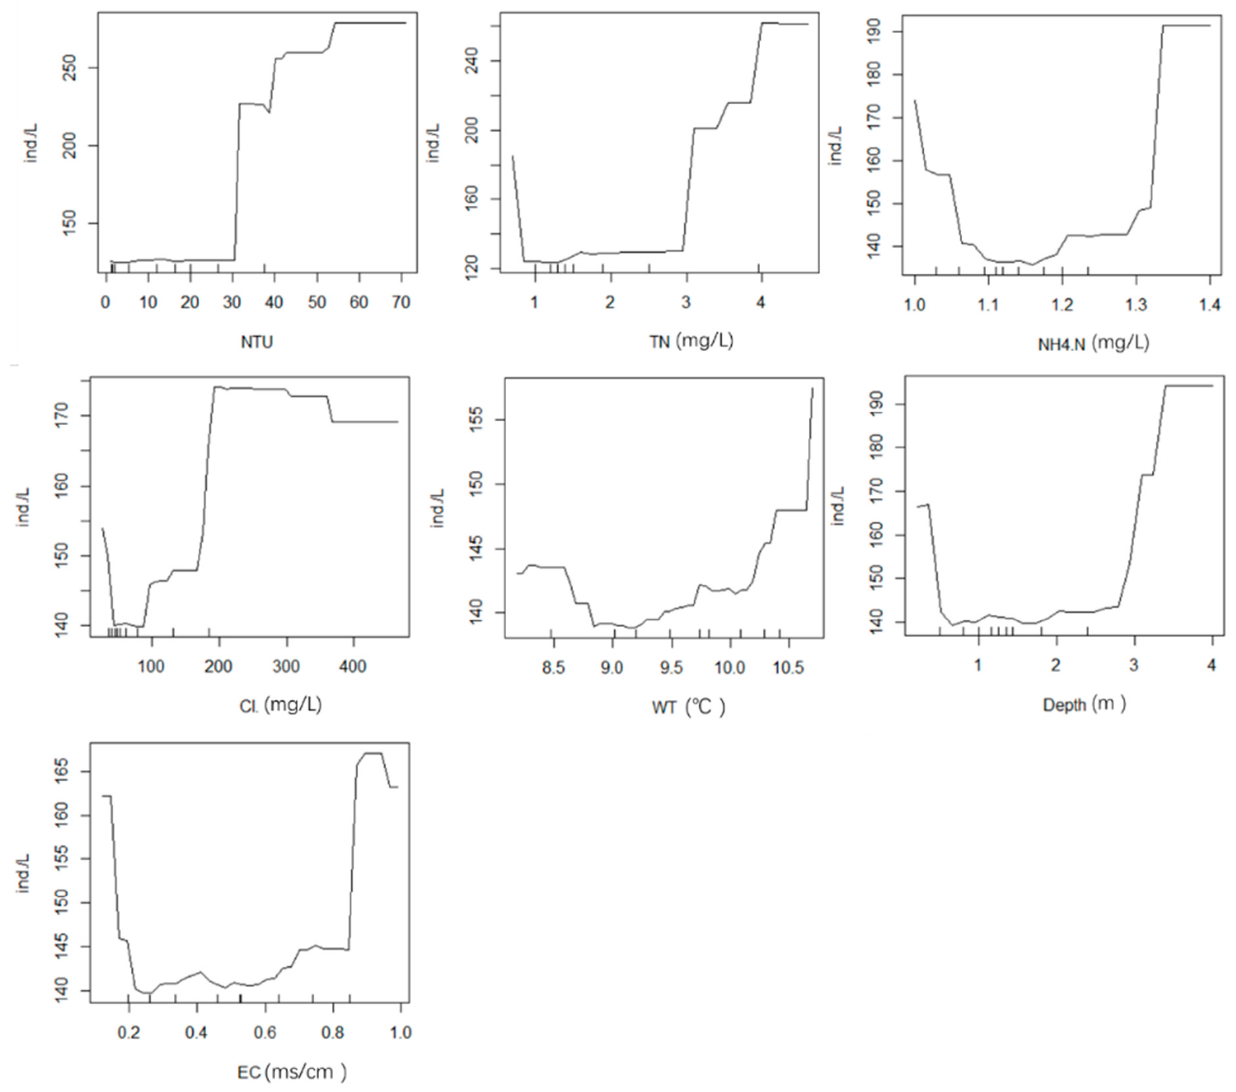
Figure 11. Effects of seven environmental drivers (NTU, TN, NH 4+ -N, Cl − , WT, depth, and EC) on phytoplankton in autumn.